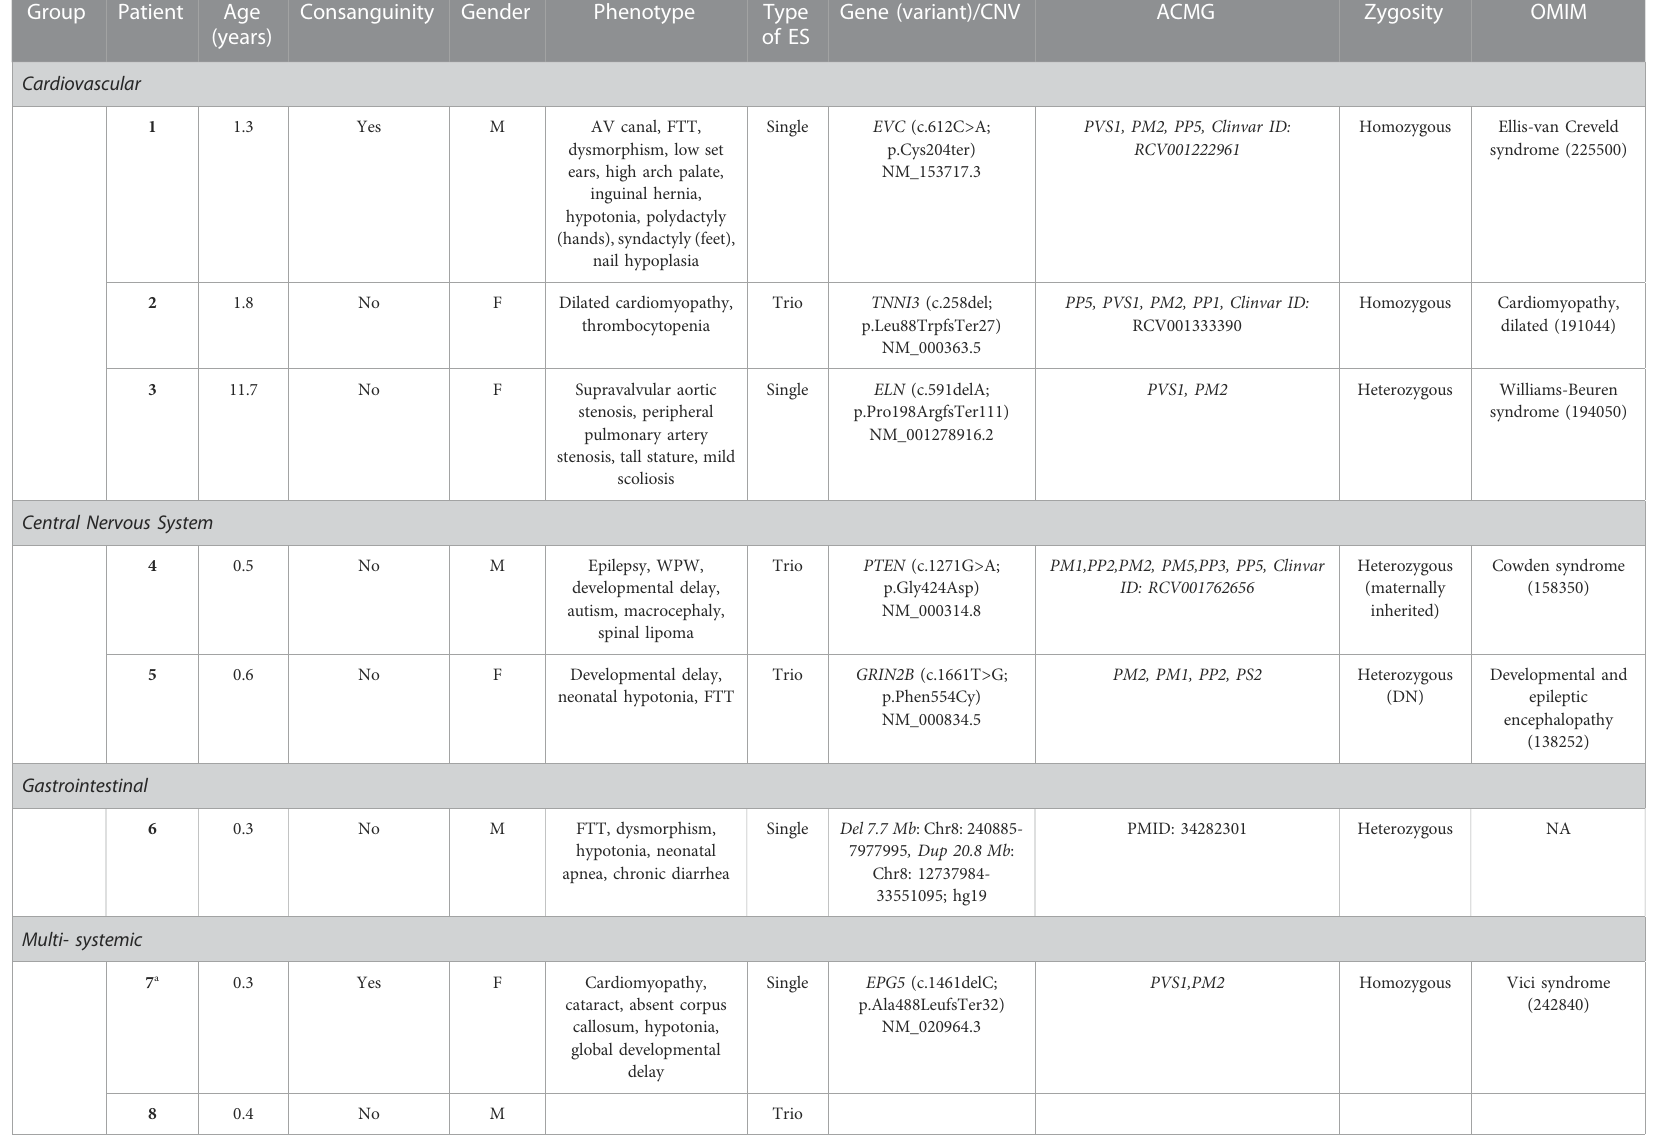
TABLE 3 Patients for whom genetic workup yielded a molecular diagnosis, shown according to clinical diagnosis and phenotype.